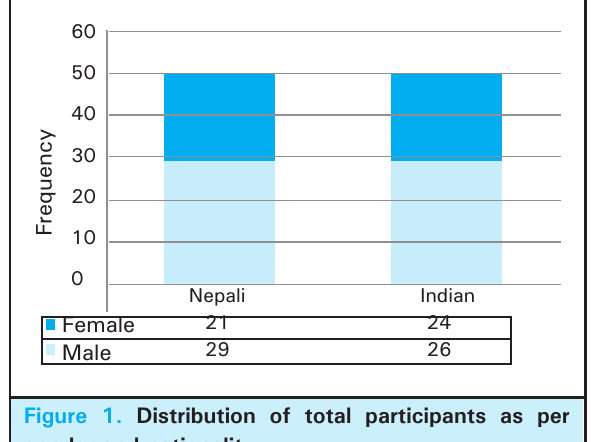
Figure 1. Distribution of total participants as per gender and nationality.